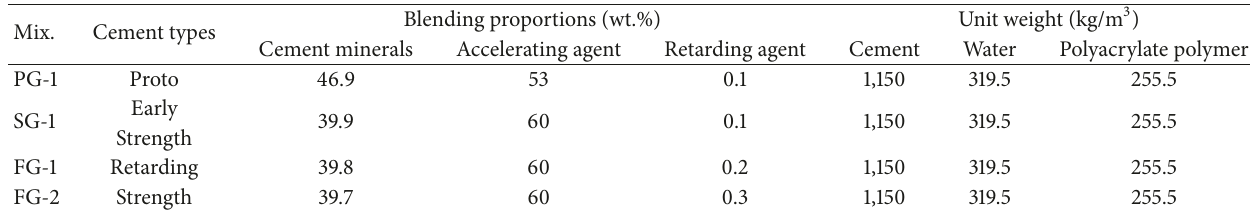
Table 2: Mixing proportions according to different types of ultrarapid hardening cement grout.